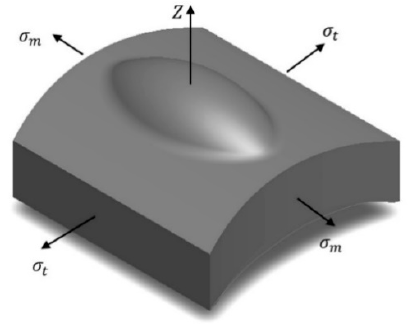
Figure 6. Scheme of stress distribution in a cavity on a flat plate.